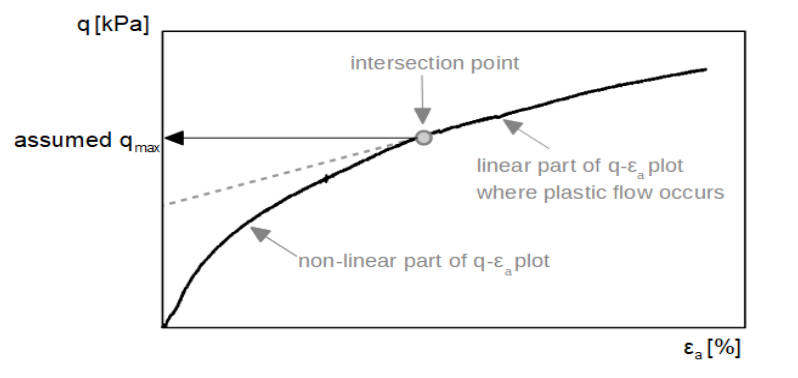
for non-standard q-ε curves. Procedure adopted after Hendry et al. (2012). max a